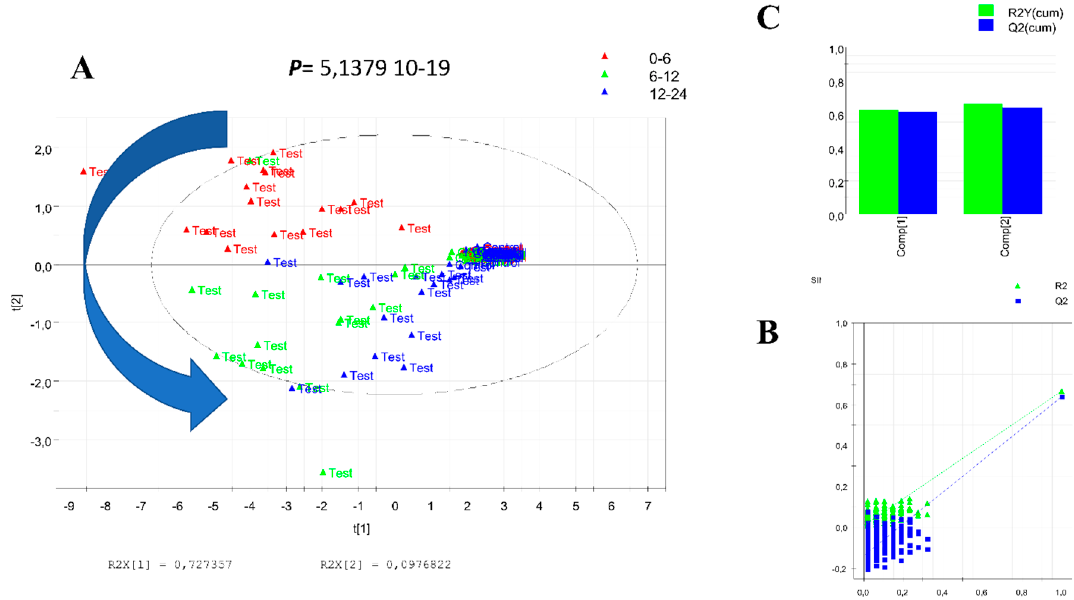
Figure 5. PLS ‐ DA analysis of nine of the most discriminant features in two conditions. ( A ) PLS ‐ DA model among control and test shows very significant (1.64587 × 10 − 22) difference between classes. ( B ) Permutation test, method validation R2 = (0.0, 0.00525), and Q2 = (0.0, − 0.13). ( C ) Two groups’ PLS ‐ DA score and the predictive model cutoff.